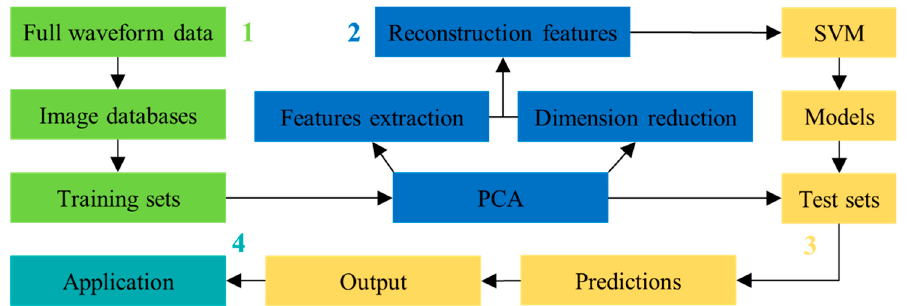
Figure 1. Main steps of the proposed waveform image discriminant method. The green, blue, yellow, and cyan squares represent steps 1, 2, 3, and 4, respectively. 1. Establishment of waveform image databases; 2. Principal component analysis; 3. Establishment of discrimination models; 4. Application of the discrimination results.